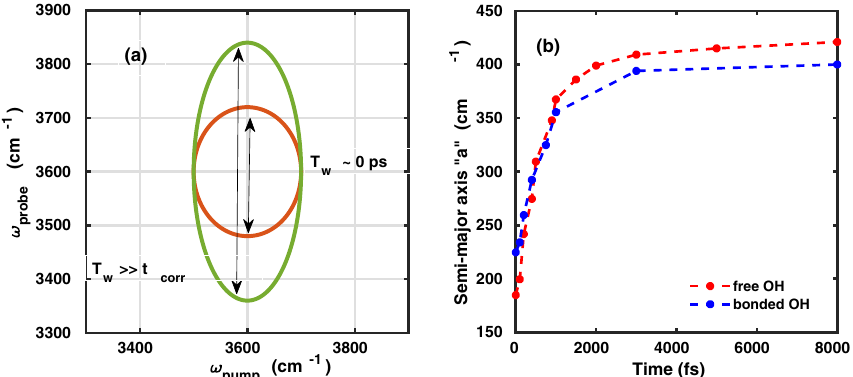
Figure 2. ( a ) 2D-vSFG in inhomogeneous limits, i.e. T w ≪ t corr , and for homogeneous limits, when T w ≫ t corr , ( b ) time-dependent evolution of parameter “a” for the free and hydrogen-bonded OH modes.